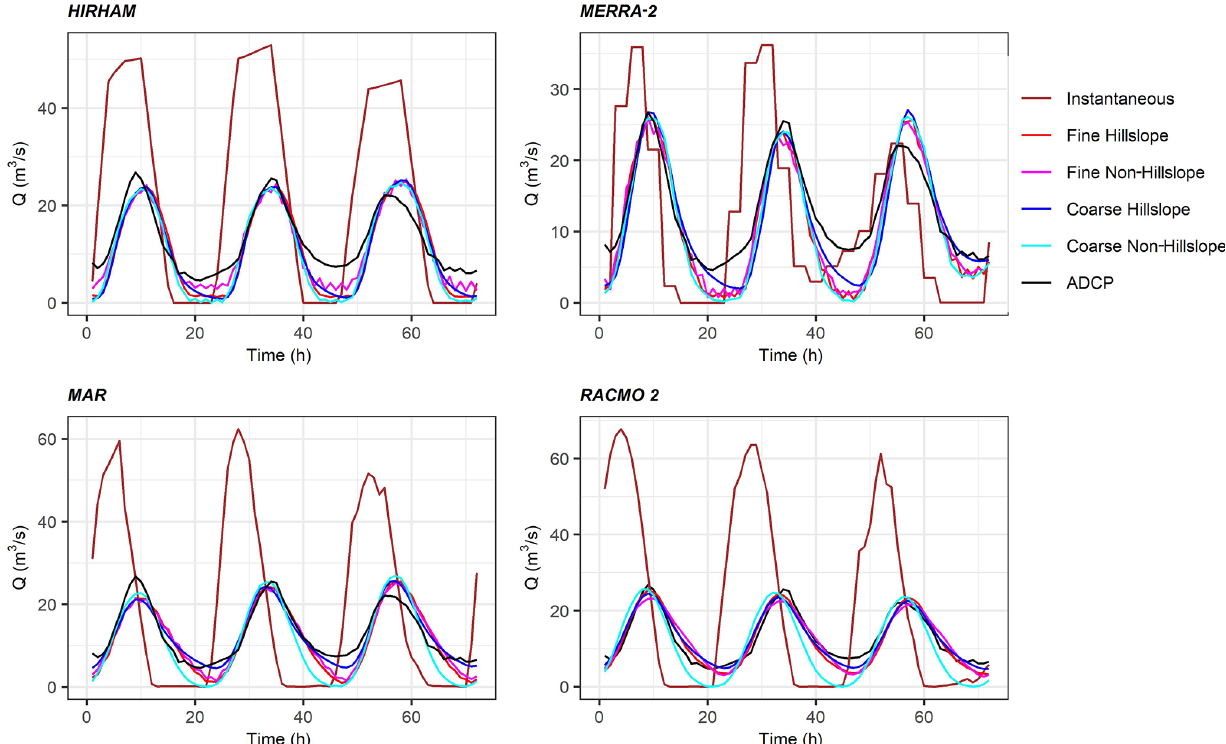
Figure 3. The hourly in situ ADCP hydrograph at the basin outlet (in black) clearly shows the necessity of delaying and reducing SMB modeled runoff (“instantaneous”, brown lines) to match field observations. Even after coupling SMB models with HRR routing models, most simulations underpredict low flows. Peak flows are relatively well modeled, although ADCP peak recession is only modeled correctly by RACMO2-forced